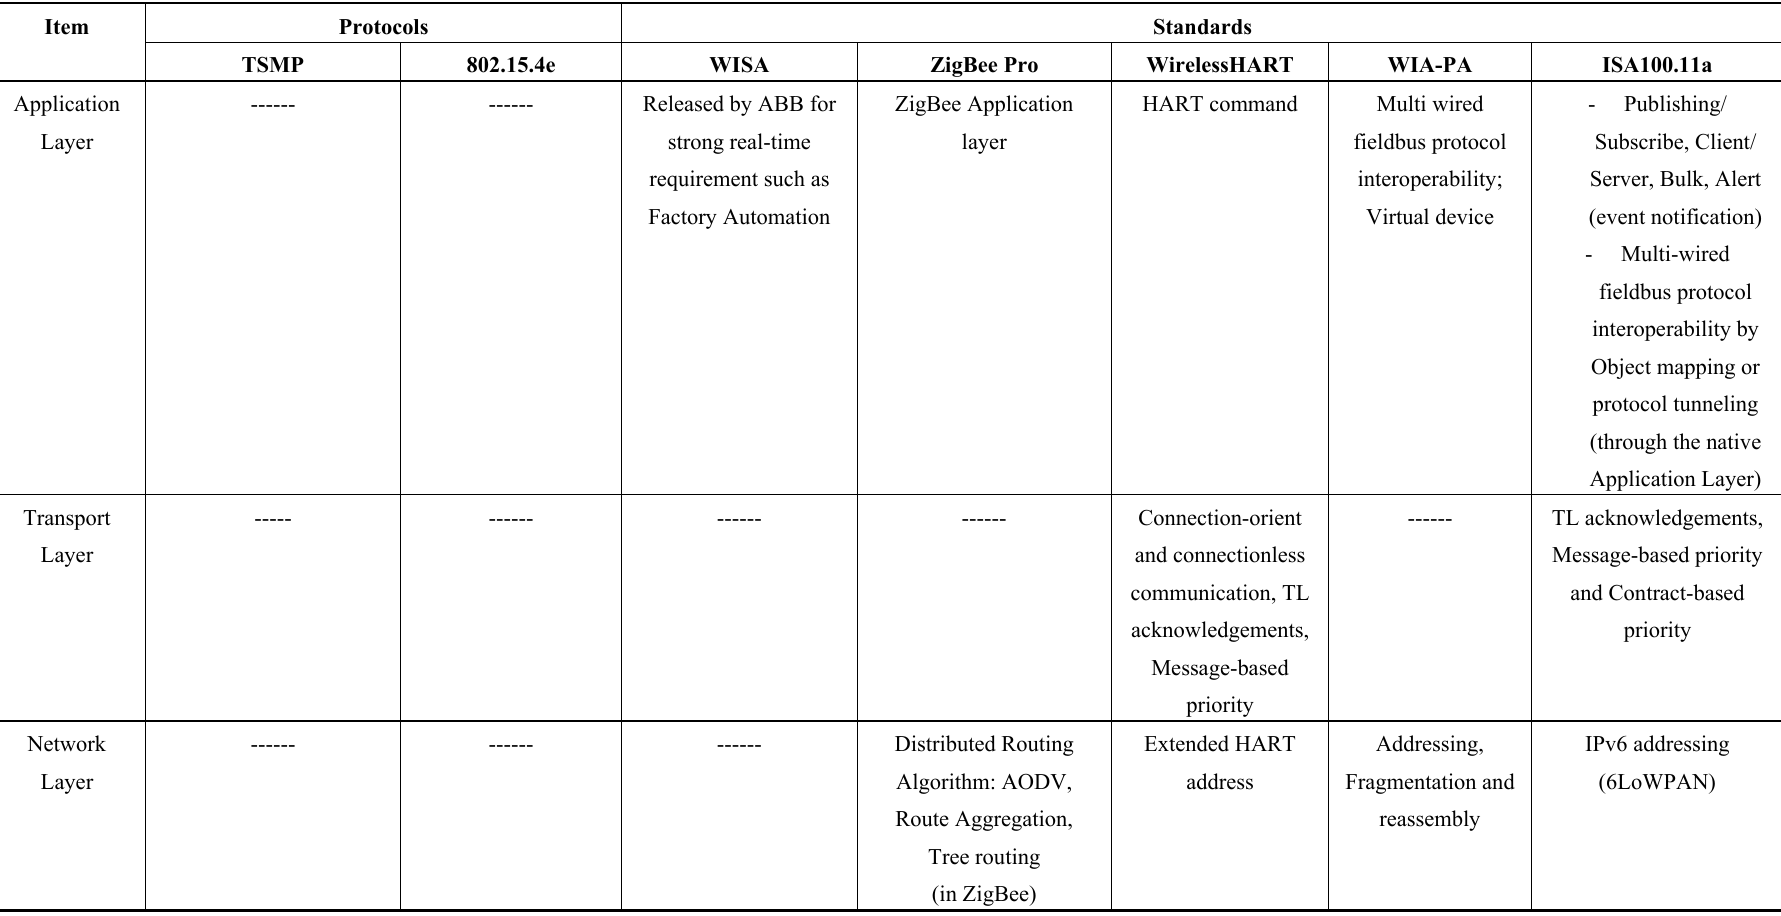
Table 1. Summary of the main features of TSMP, WISA, ZigBee Pro, WirelessHART, ISA100.11a, and IEEE